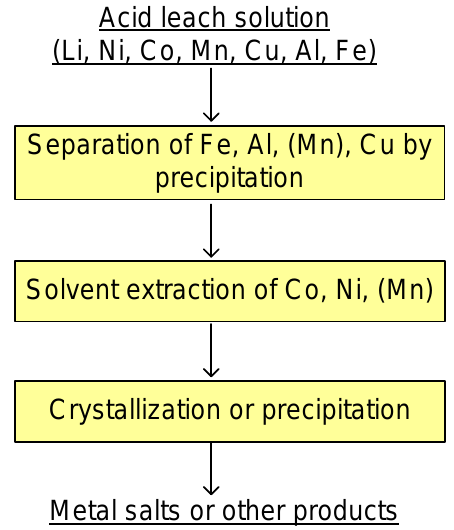
Figure 9. General flowchart for metal recovery from acidic leach solution of cathode materials. Table 6. Summary of precipitation and crystallization methods used in the recycling of Li-ion batteries. Element Process Chemical